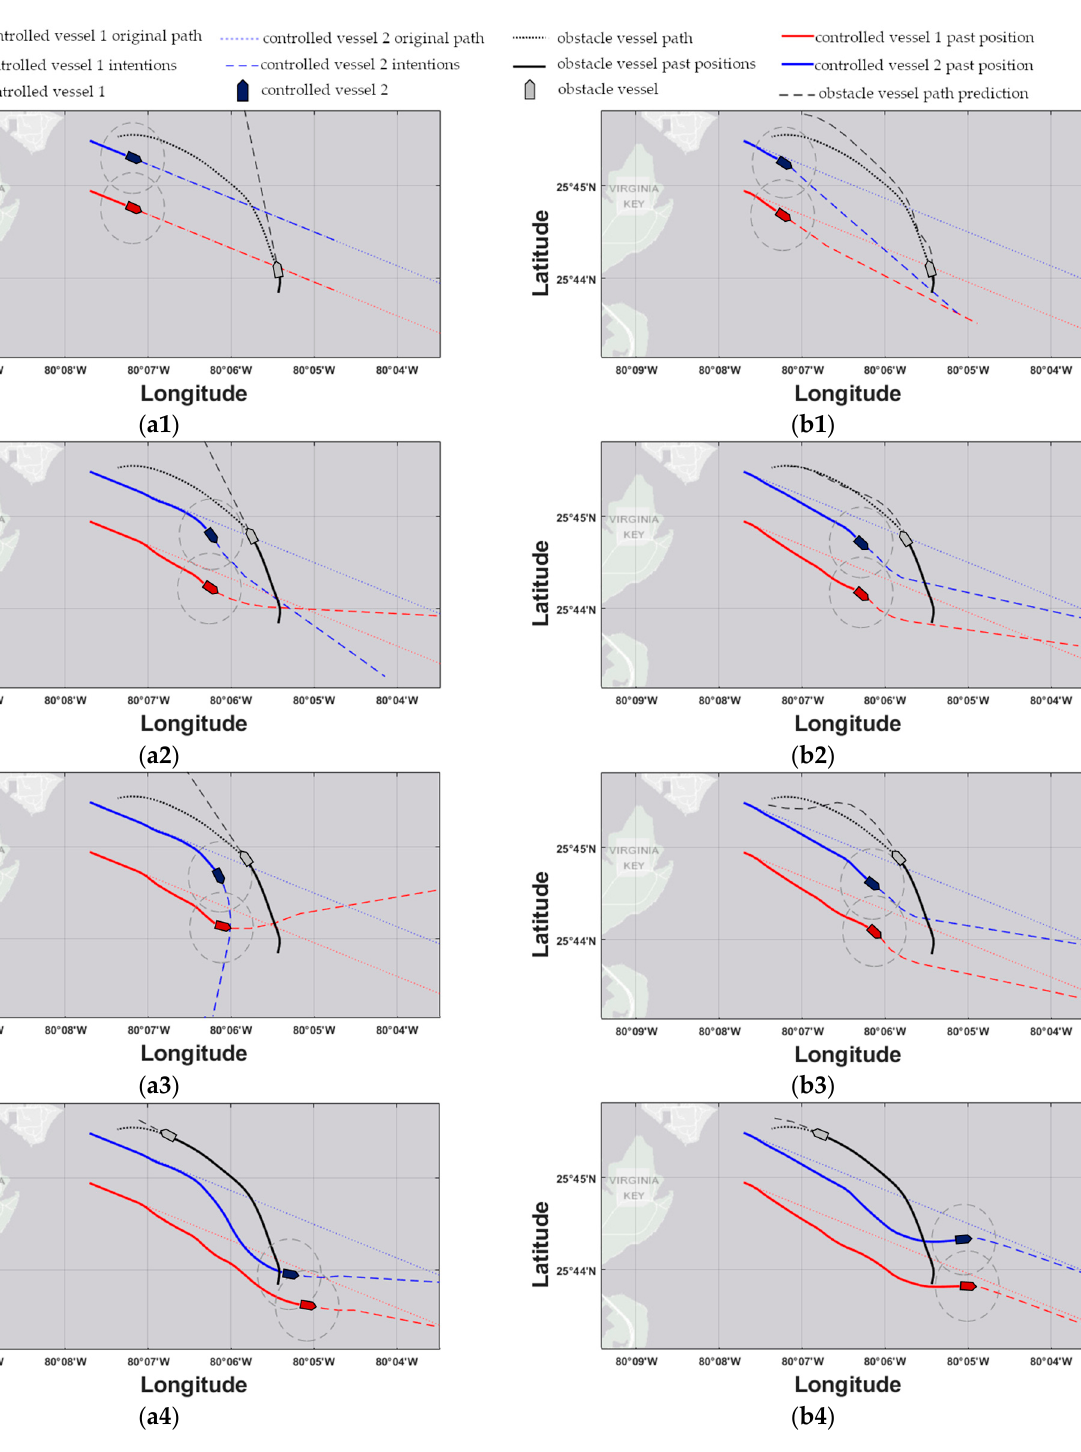
Figure 7. Scenario 1. The left subfigure column refers to the MPC-SLP scheme, while the right to the MPC-RBFP scheme. Subfigures ( a1, b1 ) refer to time instance 3 ′ , ( a2, b2 ) to 9 ′ , ( a3, b3 ) to 10 ′ , and finally, ( a4, b4 ) to 16.5 ′ .